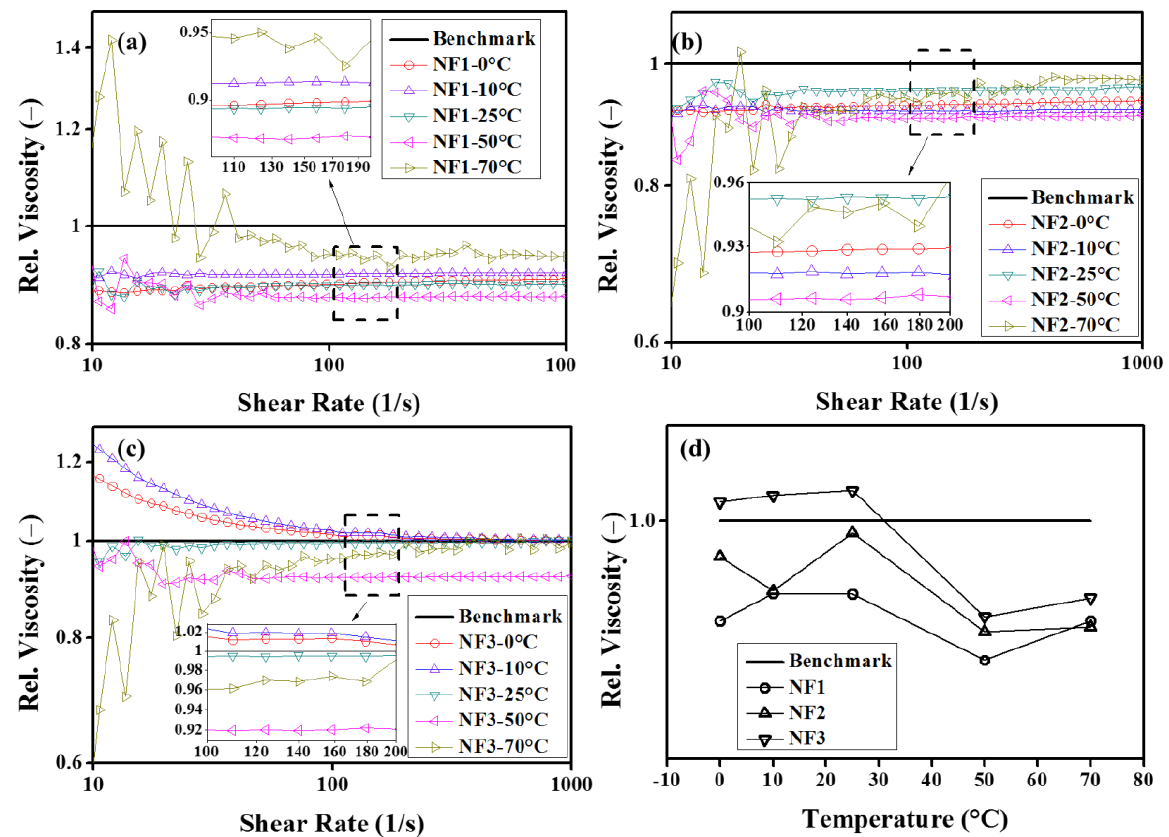
Figure 8. Relative viscosity as a function of shear rate ( a – c ) and steady-state temperature ( d ).